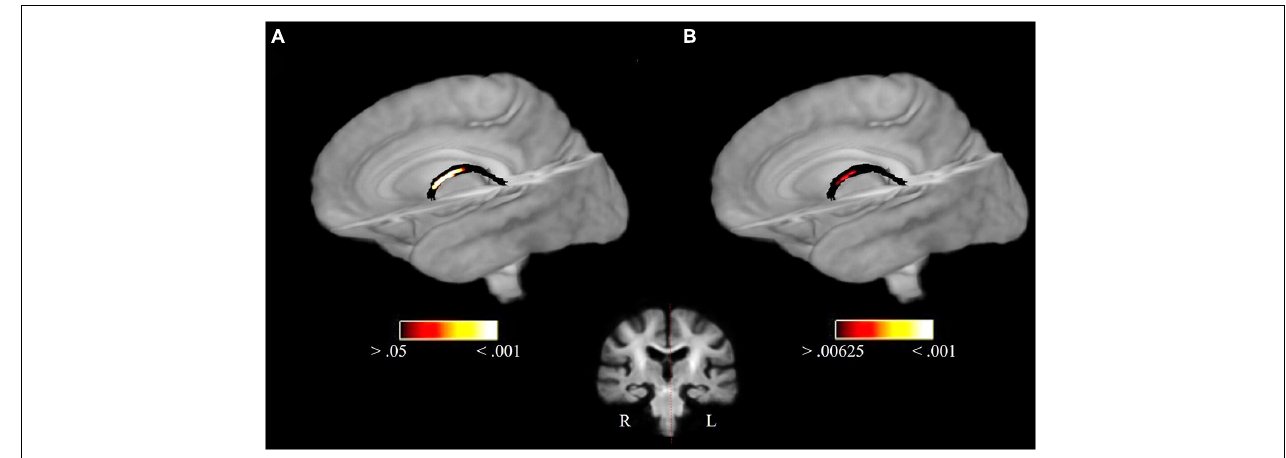
FIGURE 1 | FD group differences in the fornix for PP > MC. Significant fixels in the fornix at p FWE < 0.05 (A) and significant fixels after Bonferroni correction (p FWE < 0.00625) (B) overlaid on the population template. The coronal section shows the location of the findings.